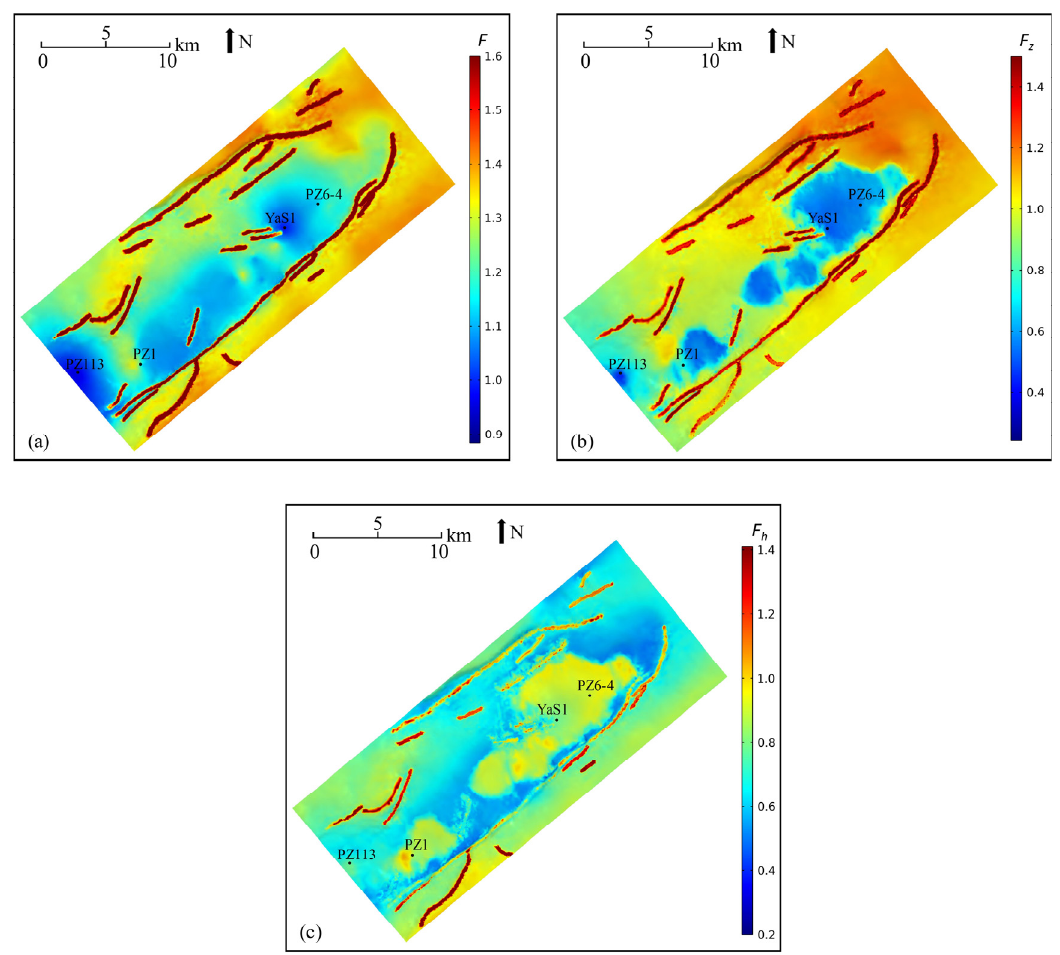
Figure 11. Plots exhibiting the predicted distribution of the degree of tectonic fracture development in the T 2 l 4 Formation during the Himalayan period. ( a ) The degree of fracture development in the fracture normal direction, ( b ) the degree of fracture development in the vertical direction, and ( c ) the degree of fracture development in the maximum horizontal